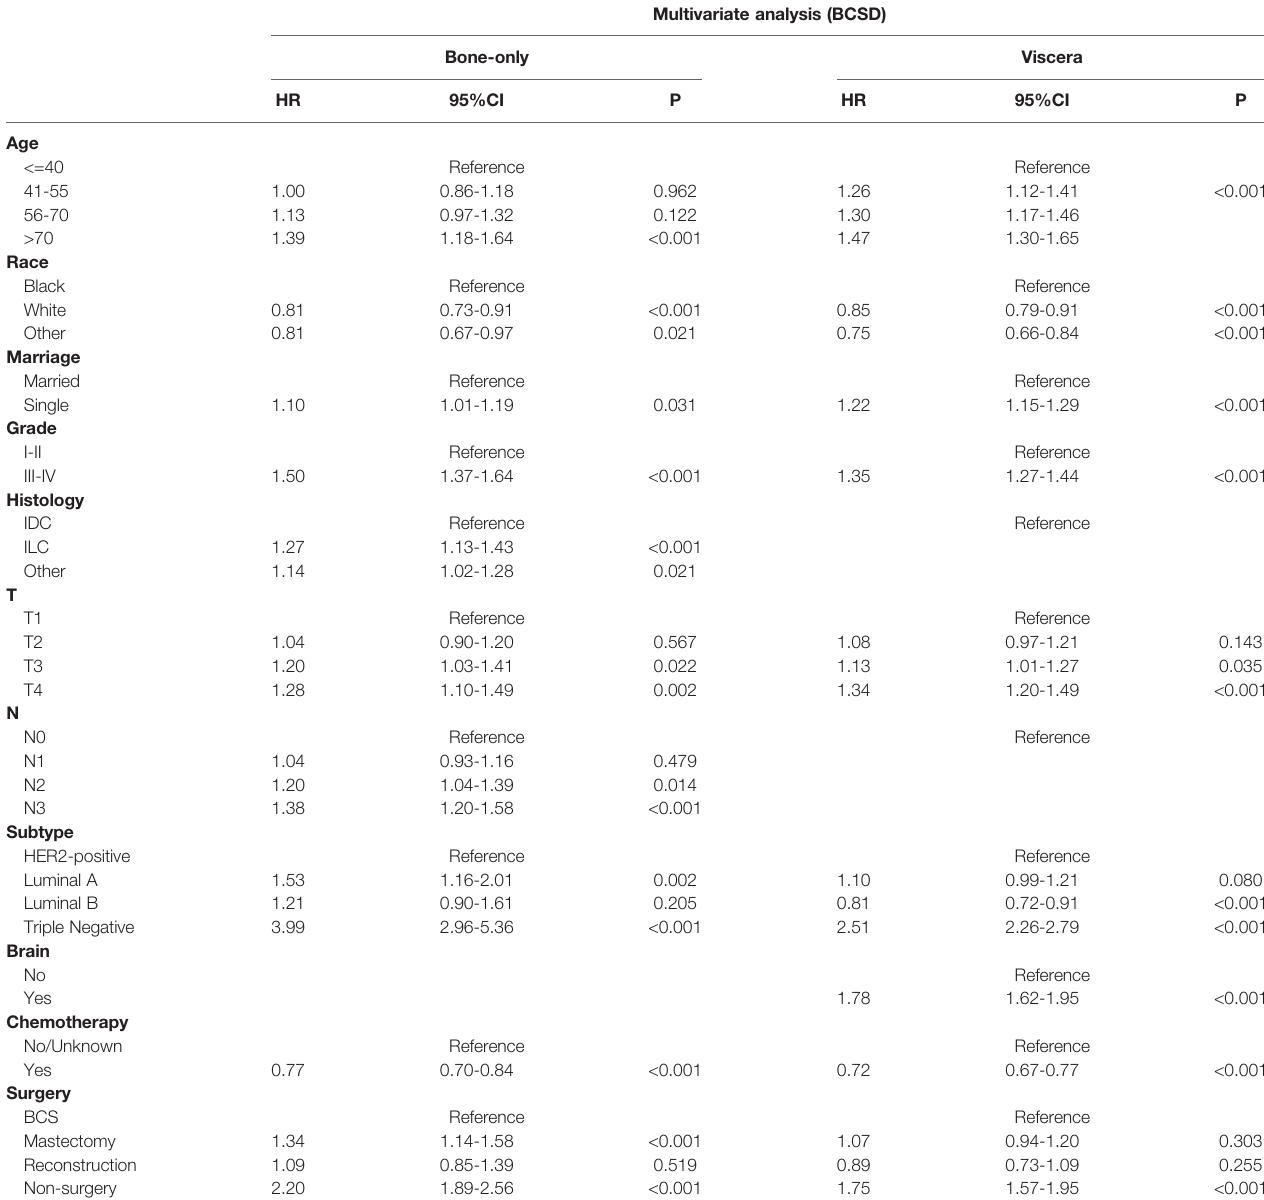
TABLE 6 | Multivariate analysis of BCSD using competing risk